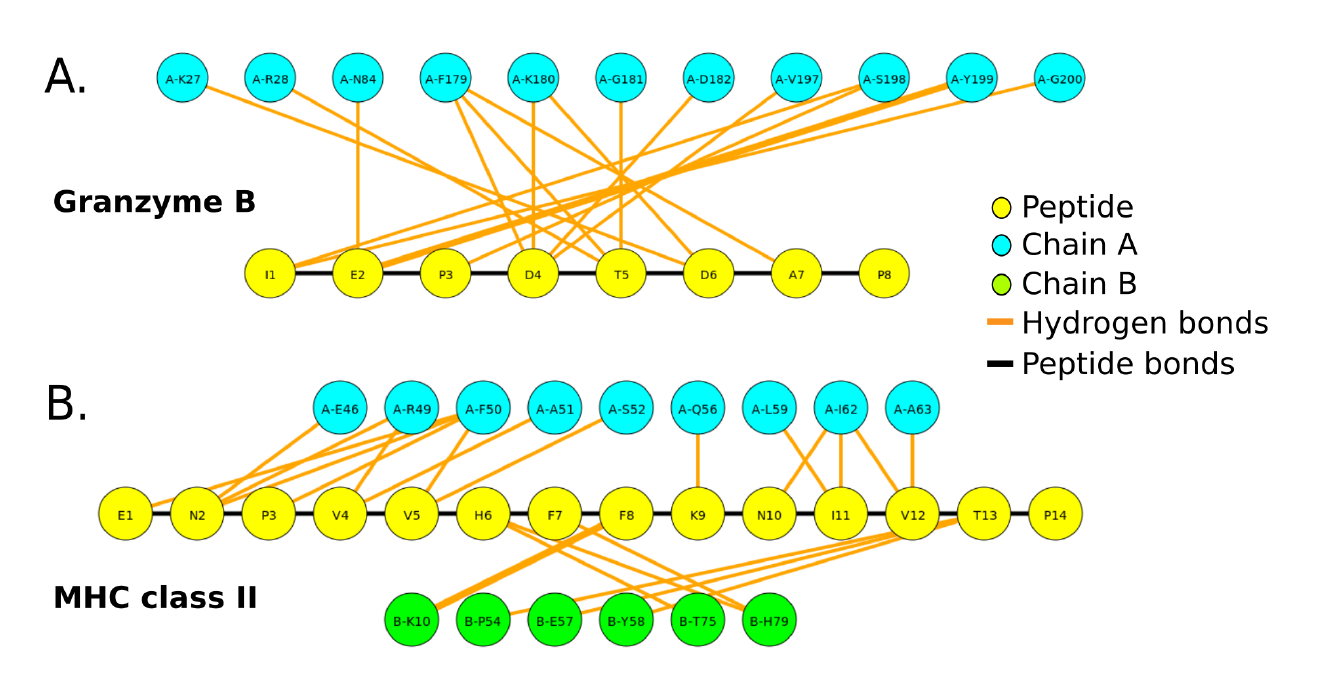
Figure 4. Visualization of potential hydrogen bonds between a peptide and residues of the protein binding site. The graphs were generated for the protease bound to an 8-mer peptide substrate ( A ), and MHC class II allele bound to a 15-mer peptide ( B ). The yellow nodes represent the peptide amino acids, and the other nodes are the residues of the protein interacting with the peptide (colored by chain). The bonds are represented by orange lines. The width of the lines is proportional to the number of hydrogen bonds between the pair of